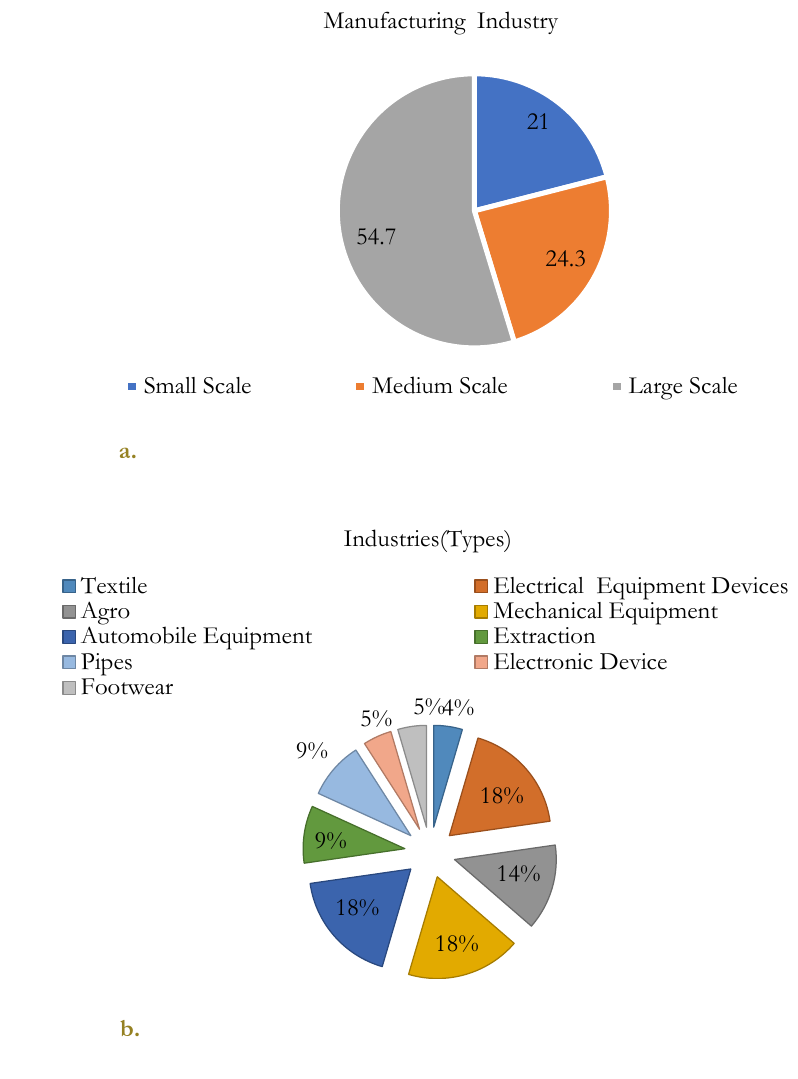
Fig. 1. Response diagrams: a. firms categorized based on investment; b. firms categorized based on product/type of